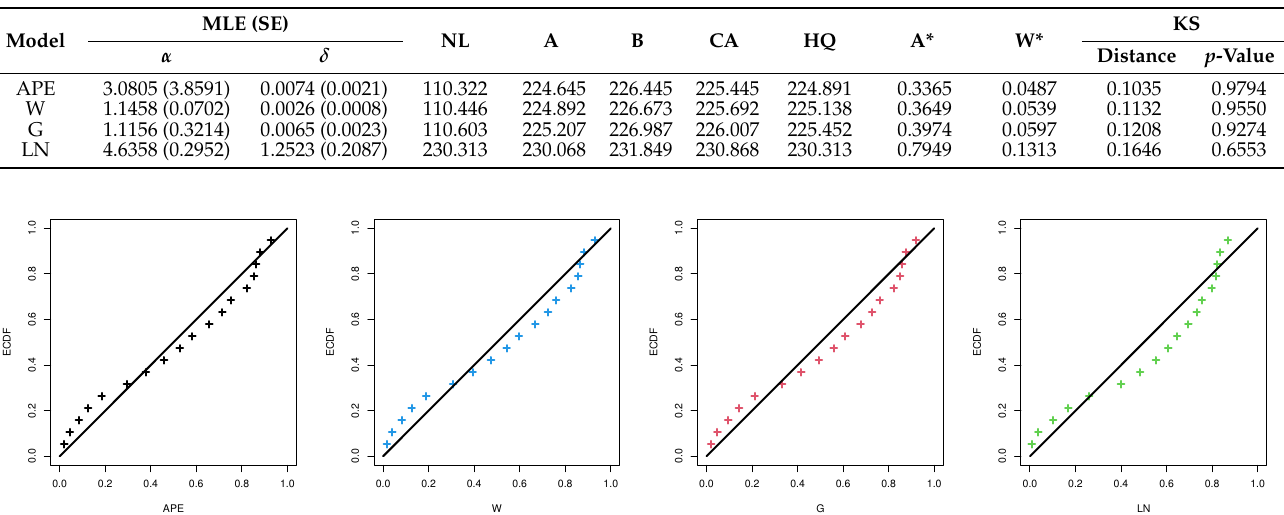
Table 9. Summary fit of the APE distribution and other competing models under electronic devices data.